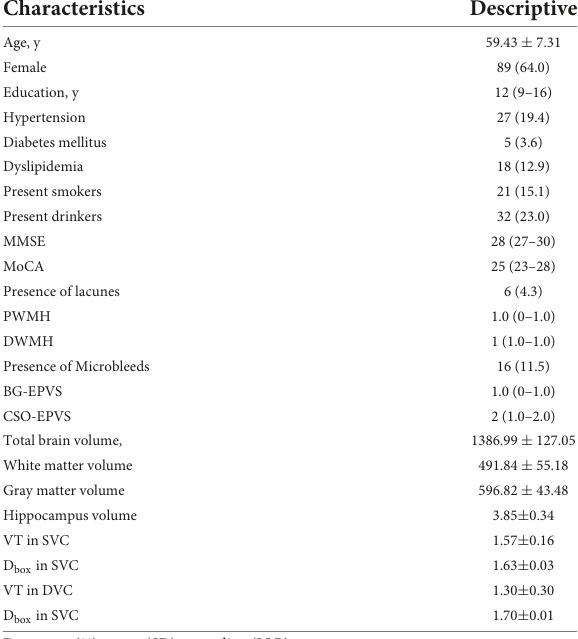
TABLE 1 Clinical and neuroimaging information of study